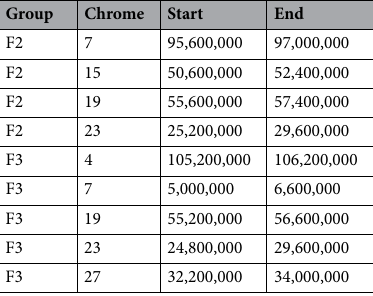
Table 2. High density of SNP between two groups (> 30